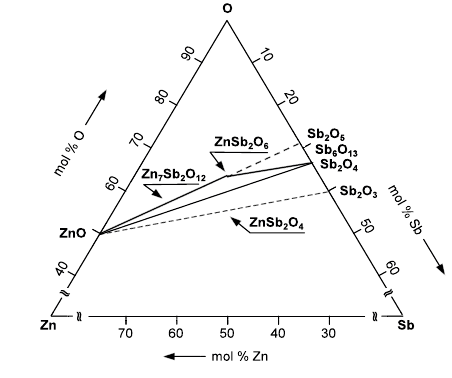
Figure 3. The location of the system, i.e. α -Sb O ; 2 6